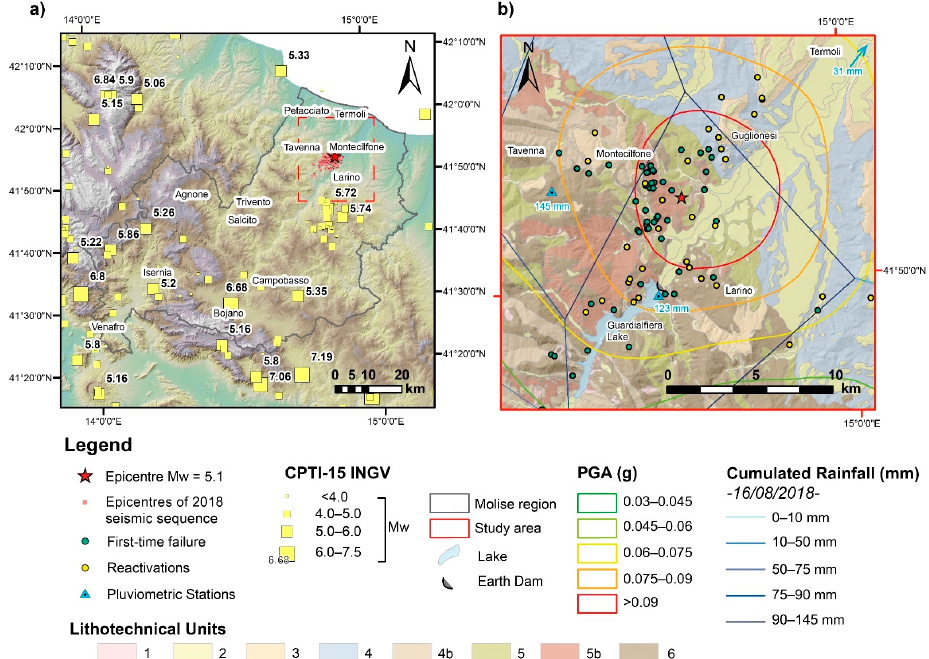
Figure 1. ( a ) Physiography of the Molise region with locations and magnitudes of historical earth- quakes in the area according to the CPTI15 catalogue [31]; location of the study area struck by the 2018 seismic sequence is highlighted by the red dashed line. ( b ) Distribution of ground effects sur- veyed and inventoried in the CEDIT catalogue [32] with respect to outcropping lithotechnical units, PGA, and cumulated rainfall in the Thiessen polygons. Outcropping lithotechnical units include: (1) landslide deposits; (2) fluvial and terraced deposits; (3) calcarenites; (4) blue clays; (4b) pelitic flysch; (5) marly clays; (5b) scaly clays; (6) arenaceous flysch. Location of the Liscione earth dam is also reported. The mainshock of the 2018 seismic sequence caused a peak ground acceleration (PGA) of up to 0.12 g (http://shakemap.rm.ingv.it ; last access 10 March 2022), which cor- responds to a return time of 745 years according to the Italian seismic hazard map (http://esse1-gis.mi.ingv.it/; last access 10 March 2022). The earthquake reflected a reduced macroseismic intensity (V–VI; EMS98 [33]) but induced an unexpected frequency and dis- tribution of ground effects [20]. Ground crackrelated to landslides were observed within an area of tens of square kilometers, resulting in an induced scenario that suggested a possible combined action of multiple destabilizing actions controlling the landslide sce- nario. The seismic event was anticipated by intense rainfall that affected the NE part of Molise region, causing a cumulative rainfall of up to 160 mm [20], with an intensity of 145 mm cumulated in three days in the epicentral area, recorded at the Palata weather station (Figure 1b). Field surveys carried out in the days immediately after the earthquake (Figure 1a) allowed us to recognize and classify 88 earthquake-induced ground effects, grouped into 75 coherent slides (earth slide and earth flow mechanisms), 9 disrupted landslides [34] (Figure 1b), and 4 ground cracks mostly related to slides.